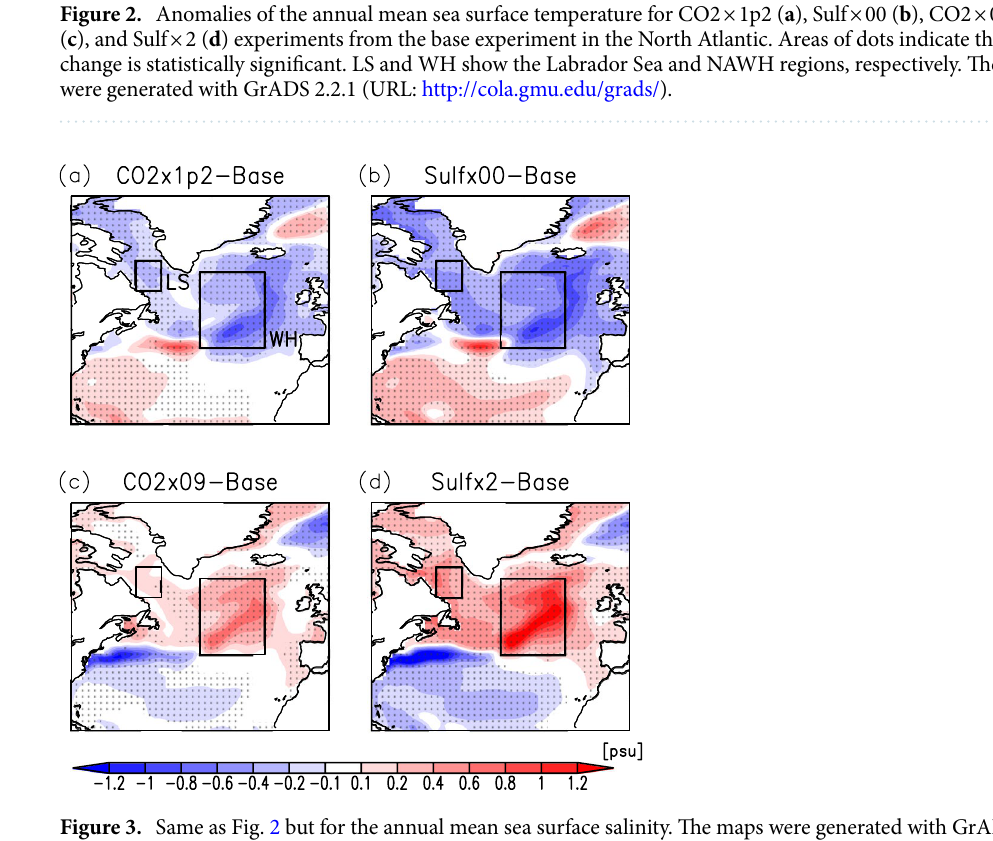
Figure 3. Same as Fig. 2 but for the annual mean sea surface salinity. The maps were generated with GrADS 2.2.1 (URL: http:// cola. gmu. edu/